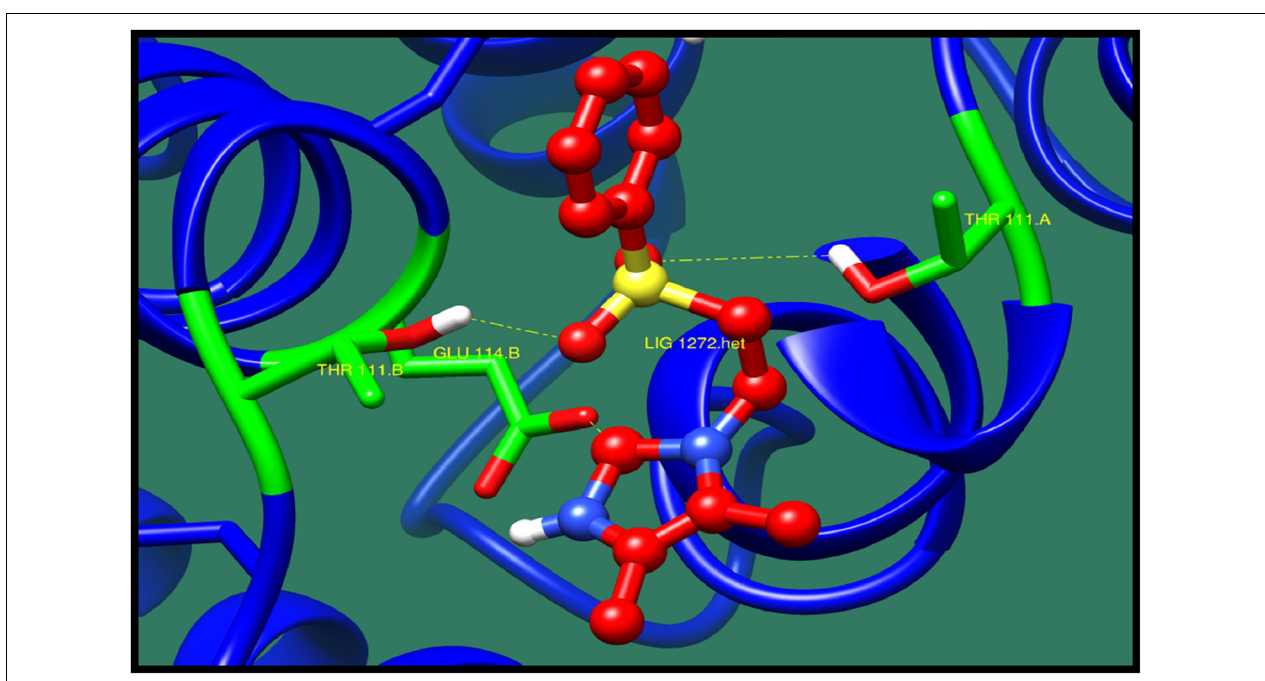
FIGURE 5 | Interaction of transcriptional regulator CtsR with ZINC79090716 (colored in red). The interacting residues (green) are shown bonding (dotted lines) with the